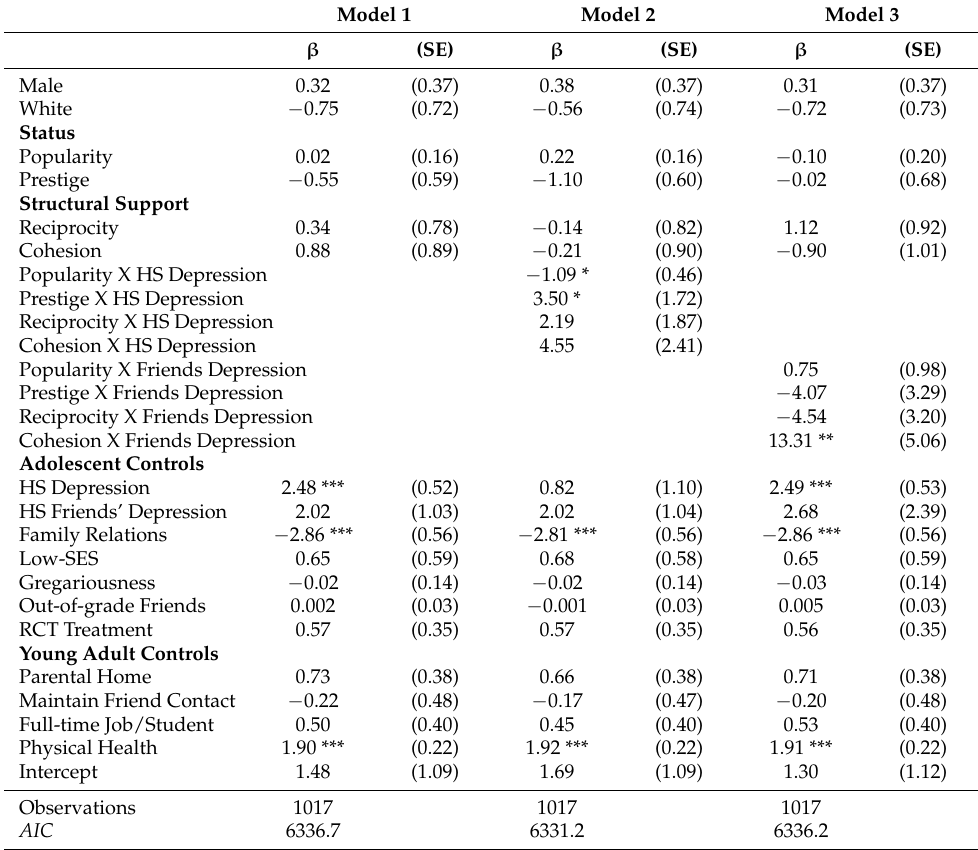
Table 2. OLS regression of depressive symptoms in young adulthood on adolescent social network status and support in PROSPER Peers a